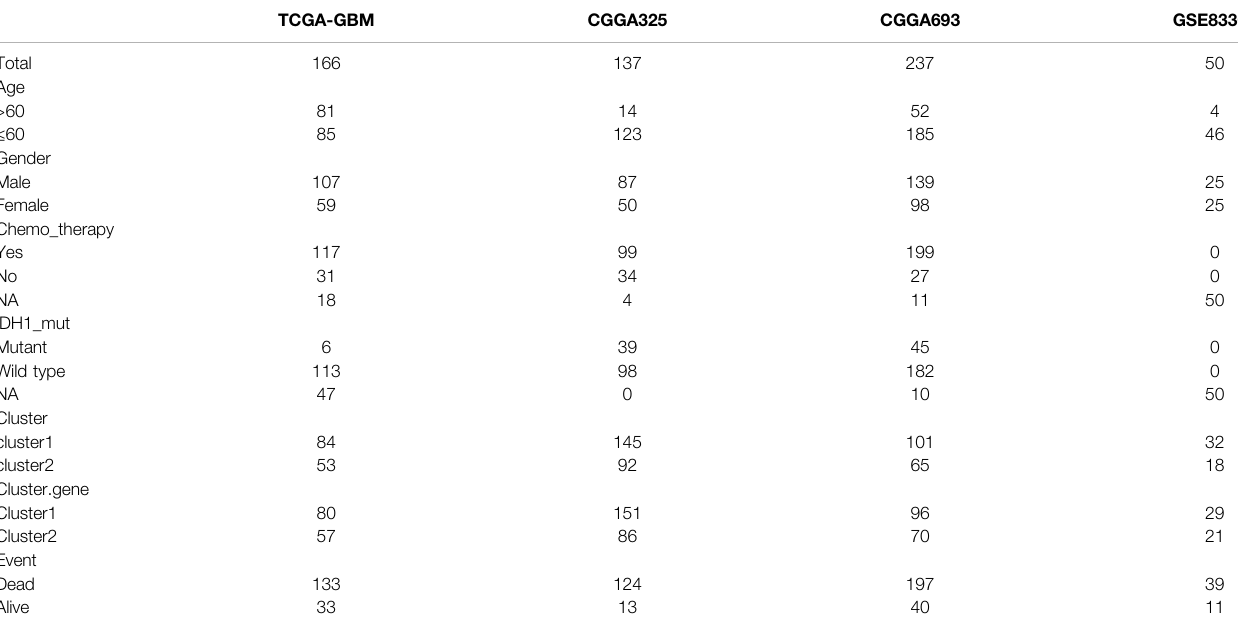
TABLE 1 | Basic characteristics of all the data.